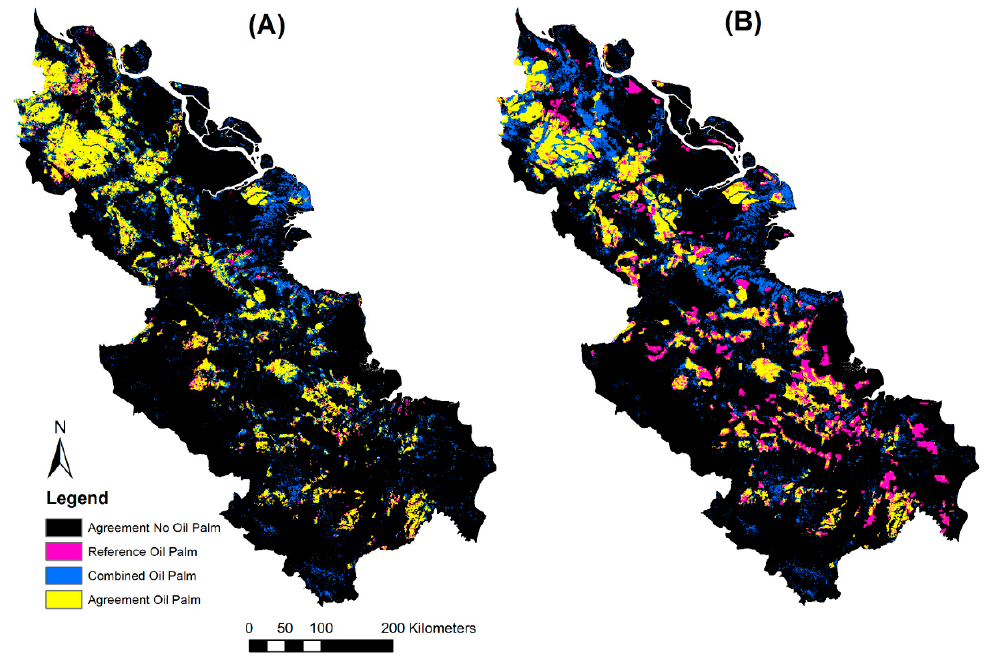
Figure 5. Difference images to compare the agreement of oil palm mapped extents for ( A ) the Combined-Miettinen2016 map and ( B ) the Combined-Austin2017 map. Black regions indicate where both maps agree that there is no oil palm, yellow regions indicate where oil palm is present in both maps, blue regions indicate where oil palm is present in the Combined map but not in the reference map (i.e., Miettinen2016 or Austin2017), and pink regions indicate where oil palm is present in the reference map but not in the Combined map.